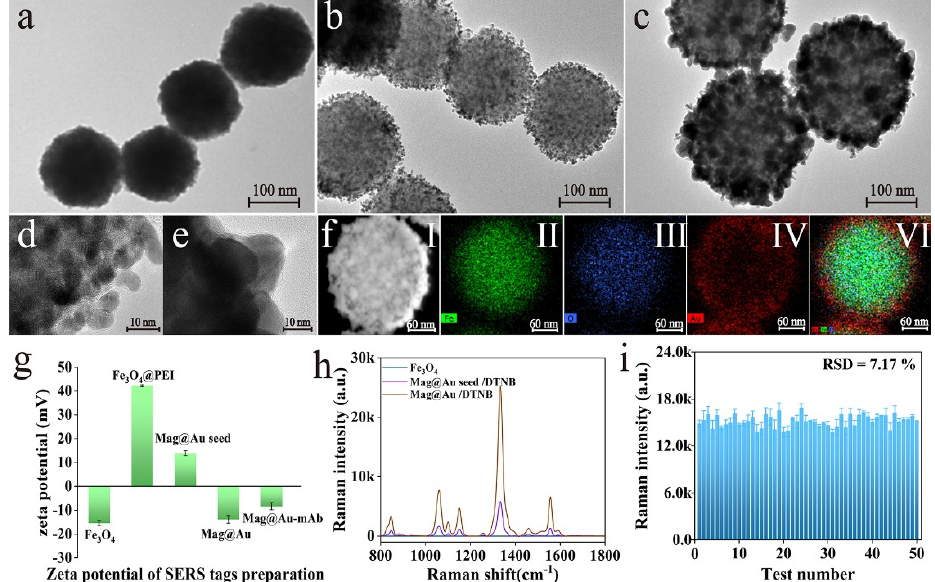
Figure 1. Characterization of synthetic Mag@Au tags. TEM images of ( a ) Fe 3 O 4 MNPs, ( b ) Mag@Au seed NPs, and ( c ) Mag@Au NPs. HRTEM images of ( d , e ) single Mag@Au seed NP and I Mag@Au NP at magnification. ( f ) Elemental mapping images of single Mag@Au NPs. ( g ) Zeta potential map. ( h ) SERS signal map. ( i ) Raman signal intensity at 1331 cm − 1 of different batches of Mag@Au tags, which was measured 50 times.